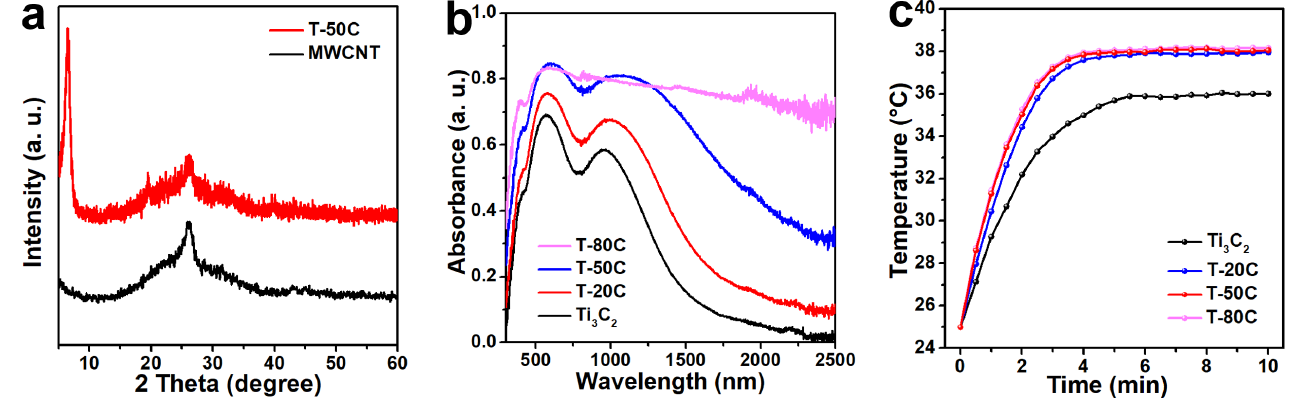
Figure 2. ( a ) XRD patterns, ( b ) UV-Vis-NIR absorption spectra and ( c ) temperature variation of the vapor over time of the Ti 3 C 2 -MWCNT membranes.